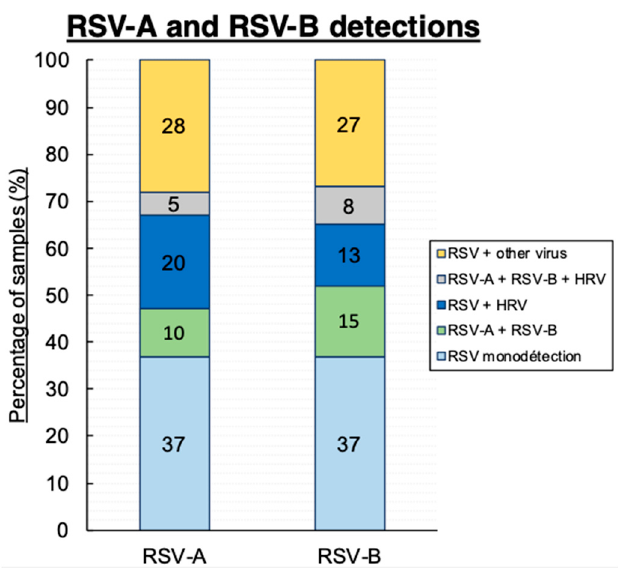
Figure 2. RSV-A and RSV-B detections